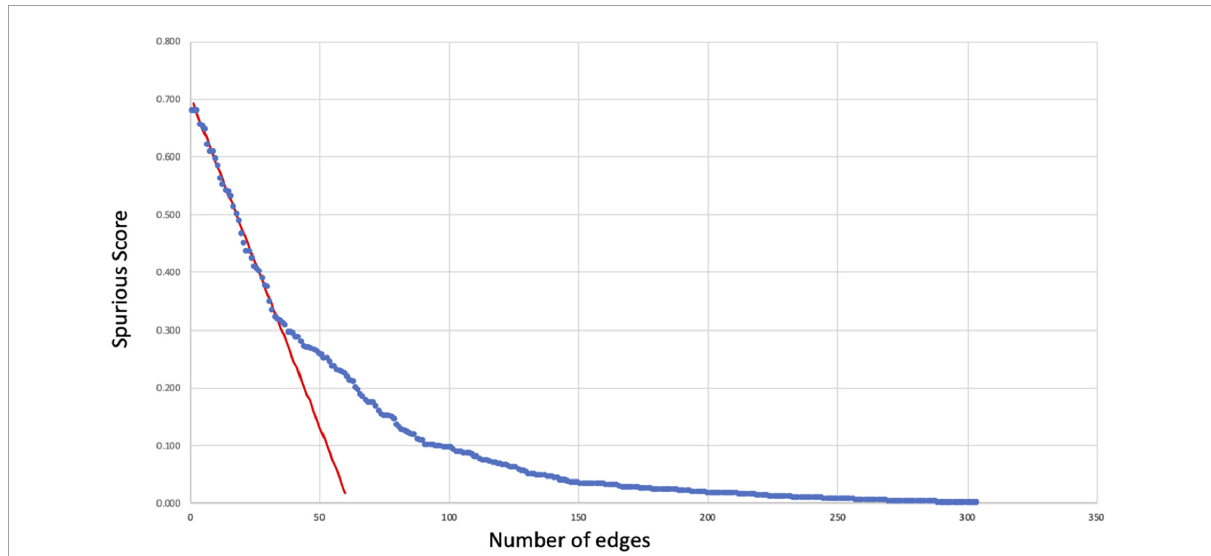
FIGURE1 Reliability of regulatory interactions. Spurious scores S ij (Eq. 1) computed for each of the initial 302 regulatory relationships (blue dots) as an estimate of the likelihood that these interactions might be false positives. These scores decrease linearly (red regression line) to S ij ∼ 30% below which the rate of change slows considerably. As a result, regulatory relationships with Sij ≥ 30% were removed as having a high likelihood of being spurious or false positive